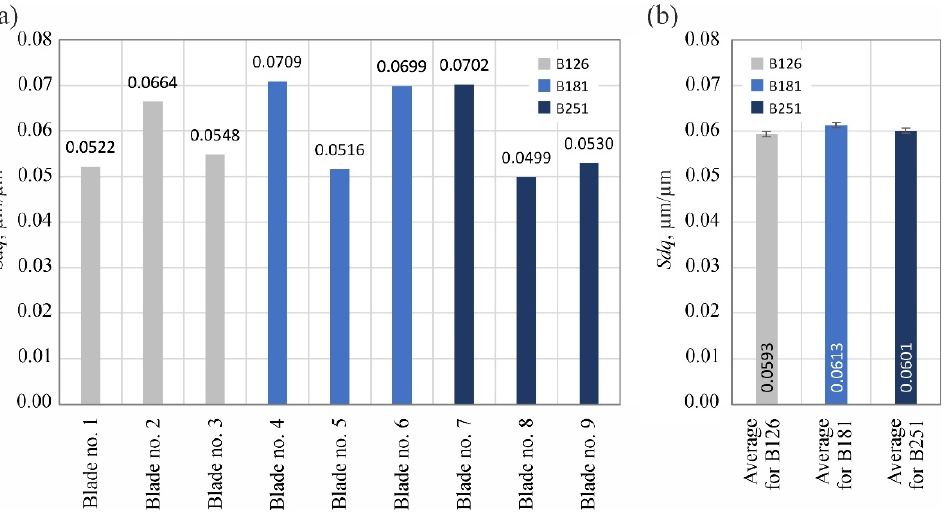
Figure 16. Changes in the root-mean-square slope of the surface Sdq : ( a ) results for nine blades selected for surface texture measurements; ( b ) average values determined by the size of the cBN abrasive grain of the grinding wheel used (error bars represent the standard error equal to the standard deviation σ divided by the square root of the total number of samples).